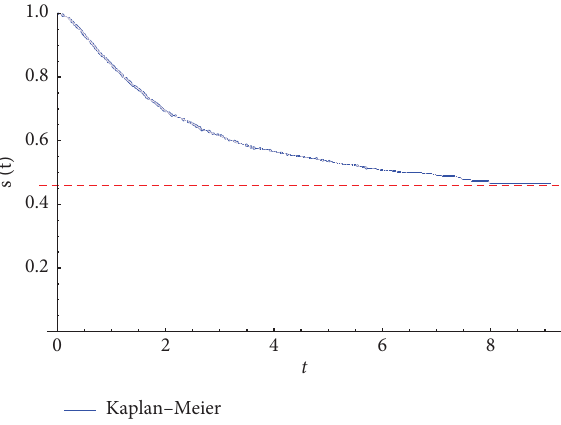
Figure 7: Kaplan–Meier estimator for the colon